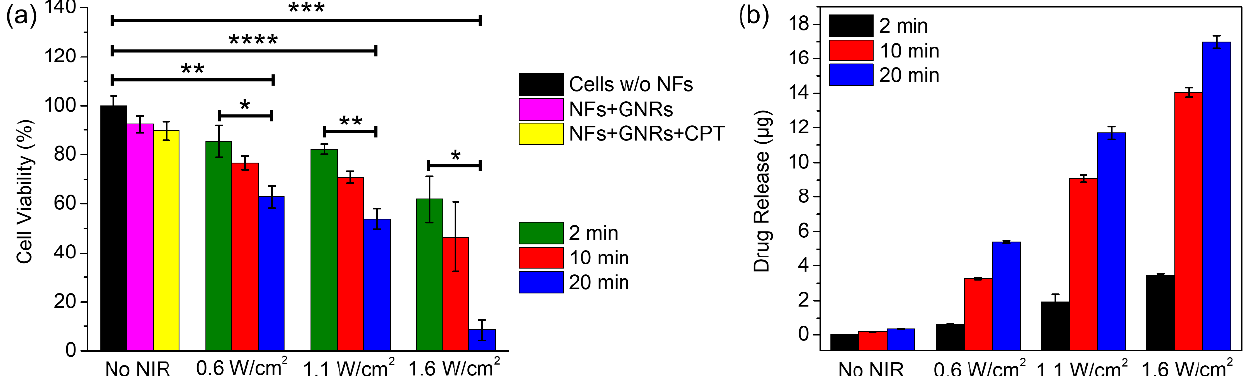
Figure 8. ( a ) Cell viability of U87 cells owing to CPT release from the nanofibers upon NIR irradiation at different time intervals. ( b ) Amount of drug release from the nanofibers upon NIR irradiation at different time intervals. * p ≤ 0.05, ** p ≤ 0.01, *** p ≤ 0.001, **** p ≤ 0.0001.